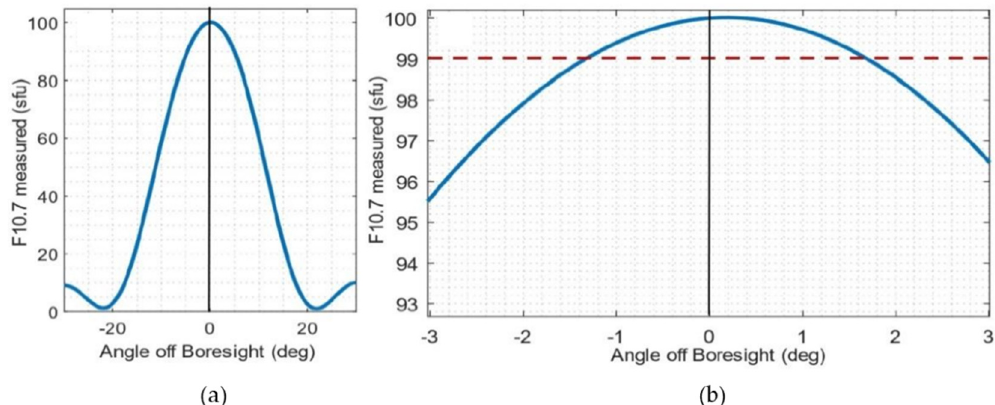
Figure 3. The effect of main beam gain on the measured F10.7 value, for F10.7 = 100 sfu. ( a ) The full main beam response. ( b ) A close-up of the central beam region. If the Sun passes through the main beam off-boresight, the measured F10.7 is lower than the actual value, as shown by the blue curve. The red line indicates the point at which the measured solar flux density is 1% less than the actual value, corresponding to an antenna gain reduction of 0.043 dBi.